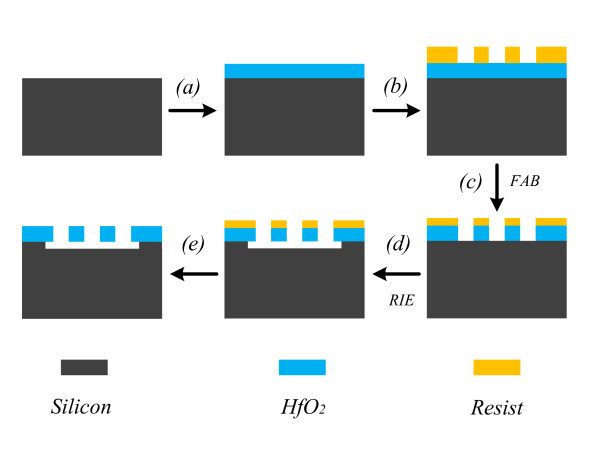
Fabrication process of freestanding HfO2 grating.